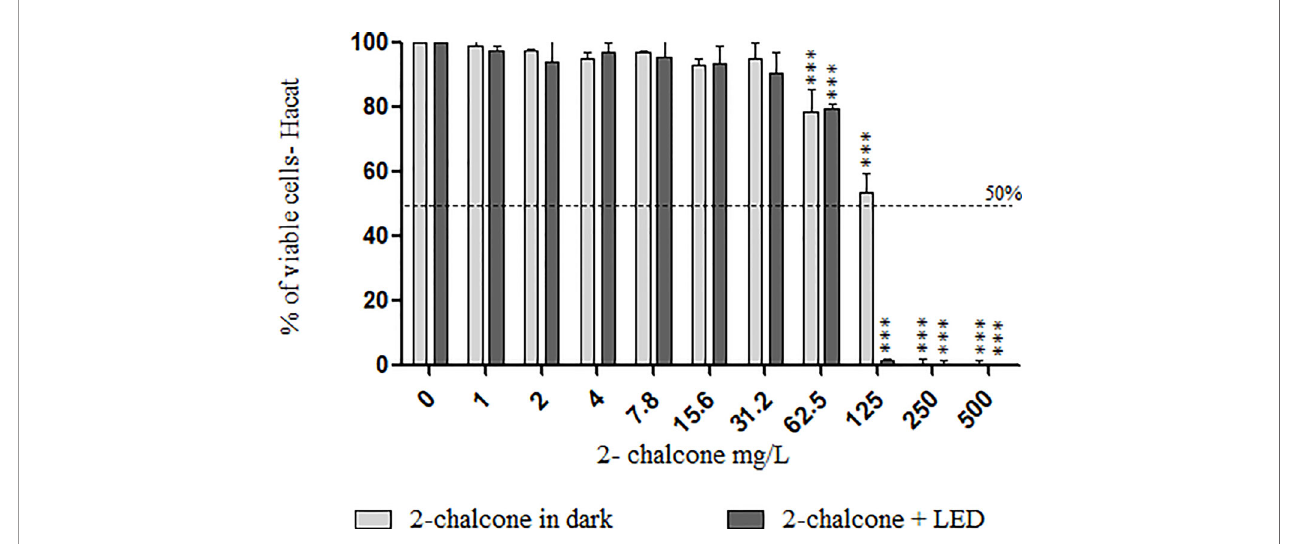
FIGURE 7 | Viability of HaCat cells measured using the resazurin reduction method after contact with different concentrations of 2-chalcone in the dark and 2-chalcone photoexcited with blue LED at a dose of 150 J/cm 2 . The compound 2-chalcone decreased viability in PDT reducing the cell viability to 80% at a concentration of 62.5 mg/L when compared to the control without treatment. On the contrary, cells treated with 2-chalcone in the dark had viability greater than 50%, even at concentrations of 125 mg/L (***p <